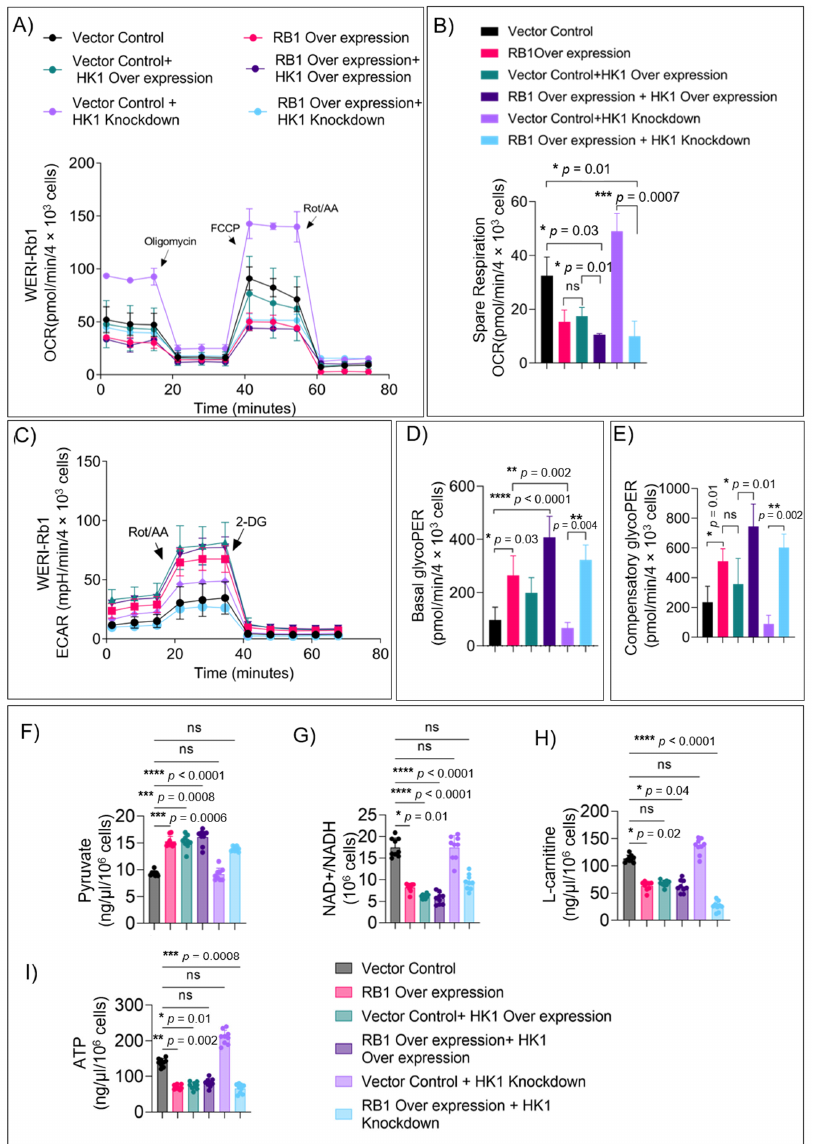
Figure 4. HK1 and RB1 expression induce a metabolic switch from mitochondrial respiration to glycolysis. ( A ) WERI ‐ Rb1 cells were transduced with indicated vectors modulating RB1 and